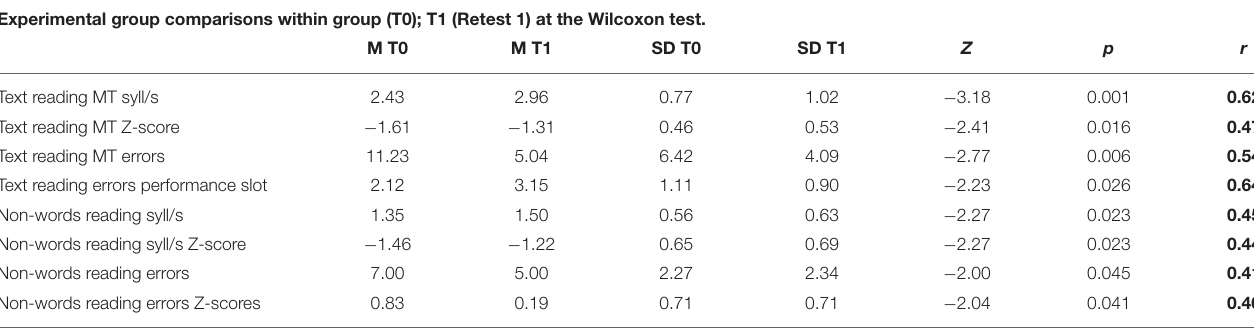
TABLE 5 | Experimental group, comparisons within group, calculated on Wilcoxon test for two dependents groups; number of subjects ( N ), mean pre and post training (M T0 and M T1), standard deviation (SD), Z -value of Wilcoxon ( Z ), p -value ( p ), effect size ( r ). Experimental group comparisons within group (T0); T1 (Retest 1) at the Wilcoxon test.